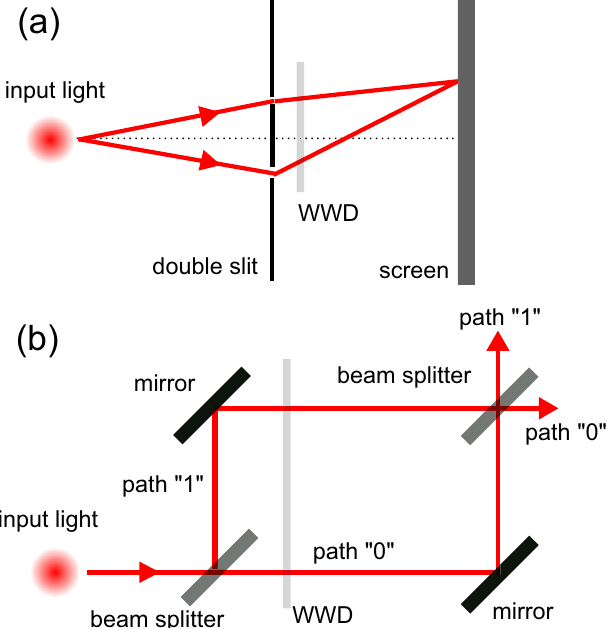
Fig. 2 Scenarios for studying wave-particle duality. a Double-slit interference setup includes a double-slit and a screen for observing the fringes. b A Mach-Zehnder interferometer consists of two beam splitters. WWD which-way